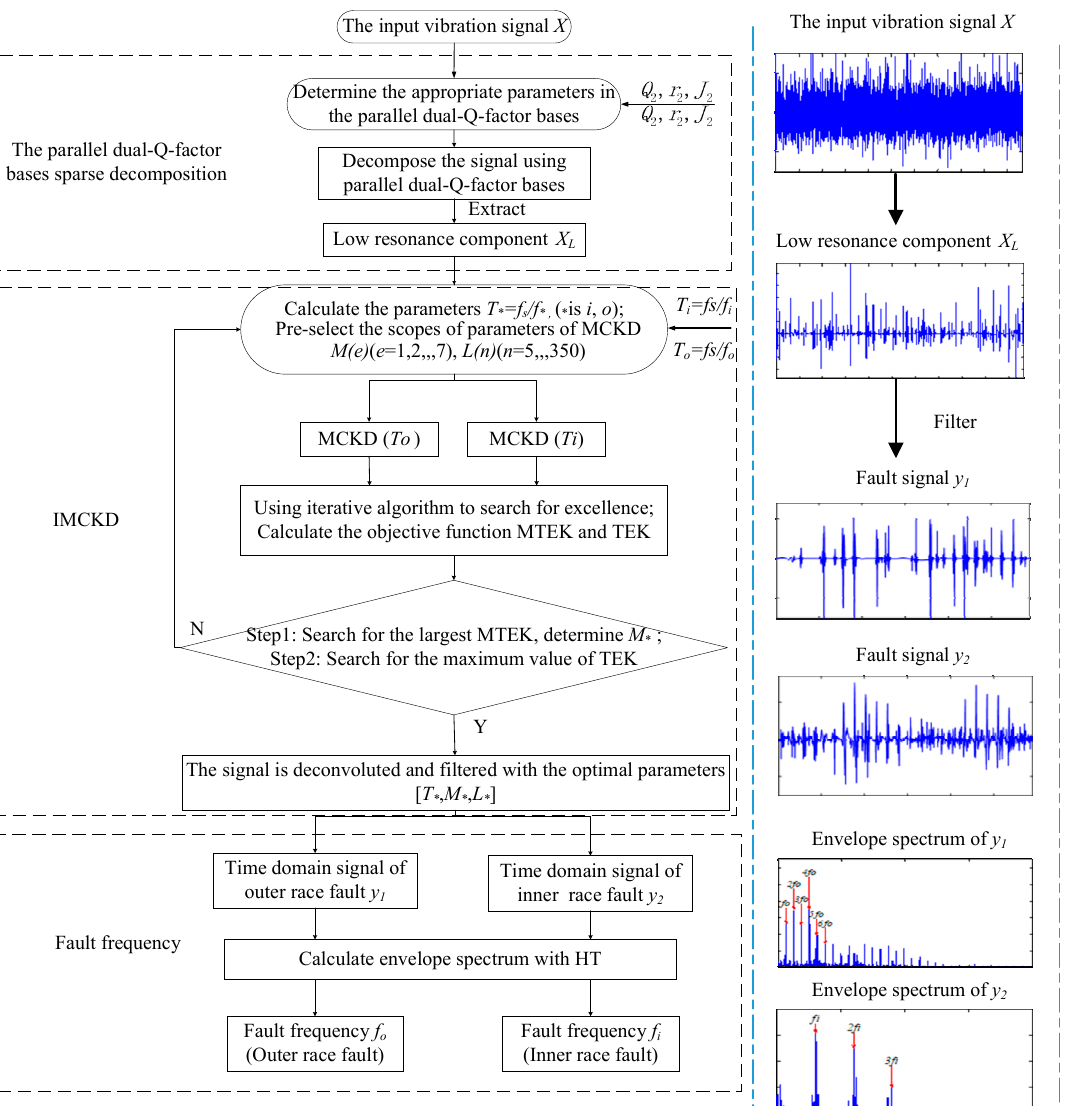
Figure 5. The flow chart of the proposed method.